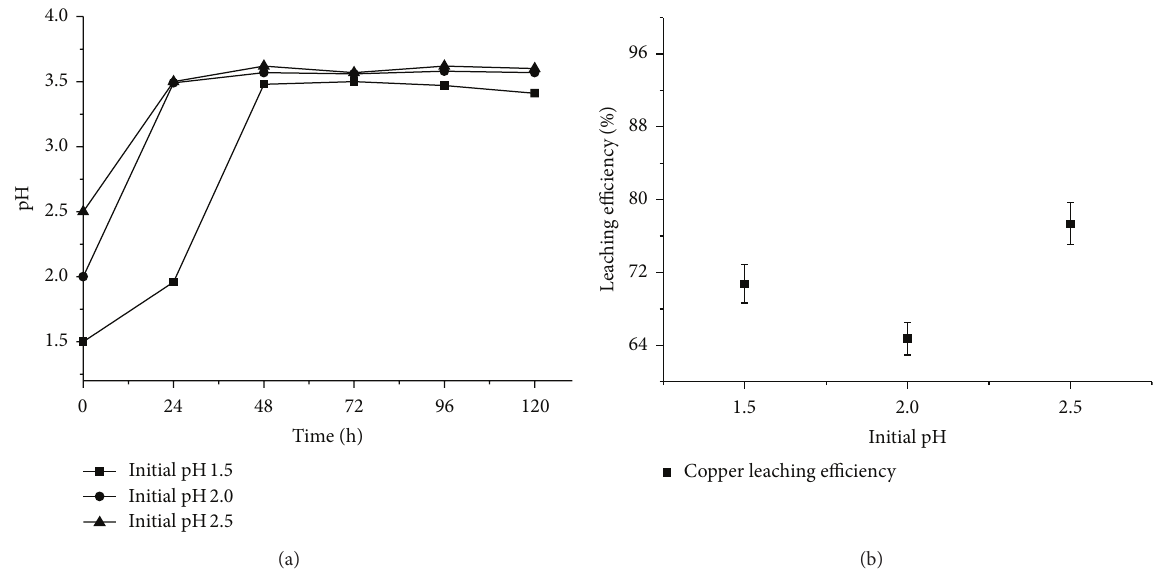
Figure 4: Different initial pH and medium pH changed with time (a) and 5 days leaching and copper leaching efficiency (b).